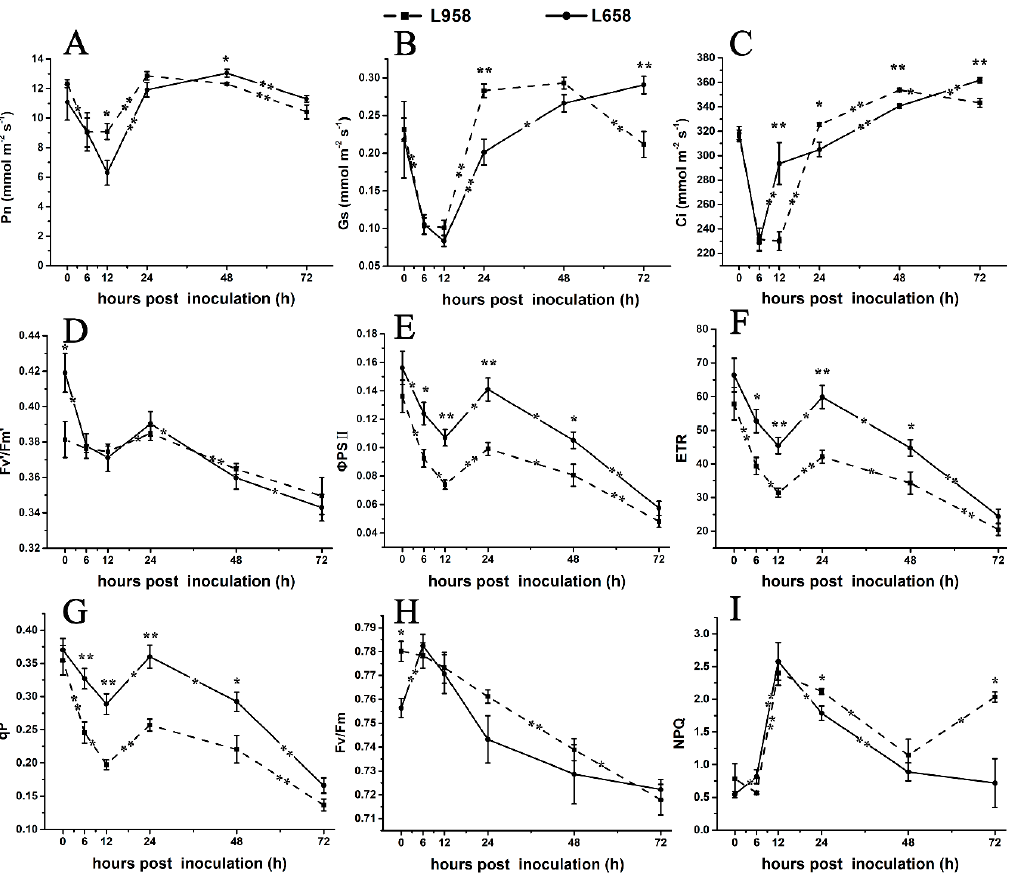
Figure 4. Changes in photosynthesis parameters and chlorophyll florescence parameters in L658 and L958. The solid and dotted lines represent different trends in the Pn ( A ), Gs ( B ), Ci ( C ), Fv’/Fm’ ( D ), Ф PSII ( E ), ETR ( F ), qP ( G ), Fv/Fm ( H ), and NPQ ( I ) in L658 and L958. The meanings of the symbols are the same as those in Figure 1. The asterisks represent significant differences as follows: ** p < 0.01 and * p < 0.05. The asterisk at the top of the line chart represents the difference between L658 and L958 at each time point. The asterisk on the trend line represents the difference between two adjacent time points for the same genotype.